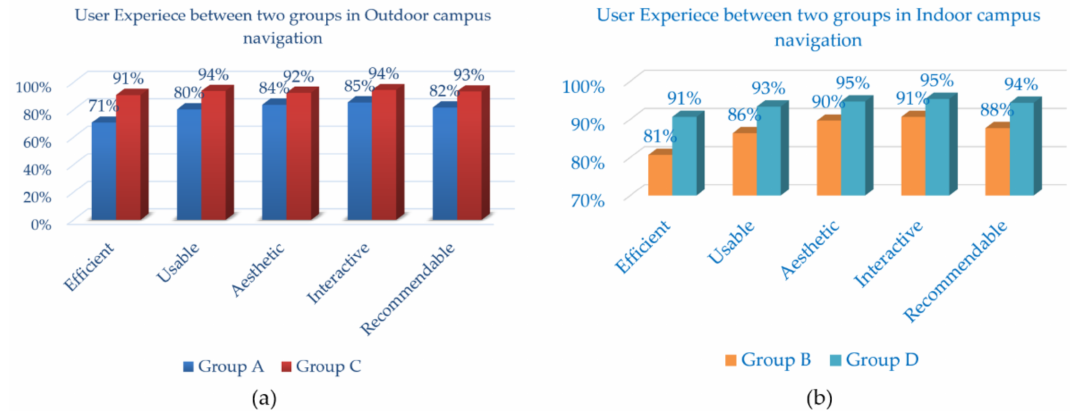
Figure 10. The agreement rate of user experience between four groups in outdoor and indoor campus navigation. ( a ) User experience between group A and group C in outdoor campus navigation. ( b ) User experience between group B and group D in indoor campus